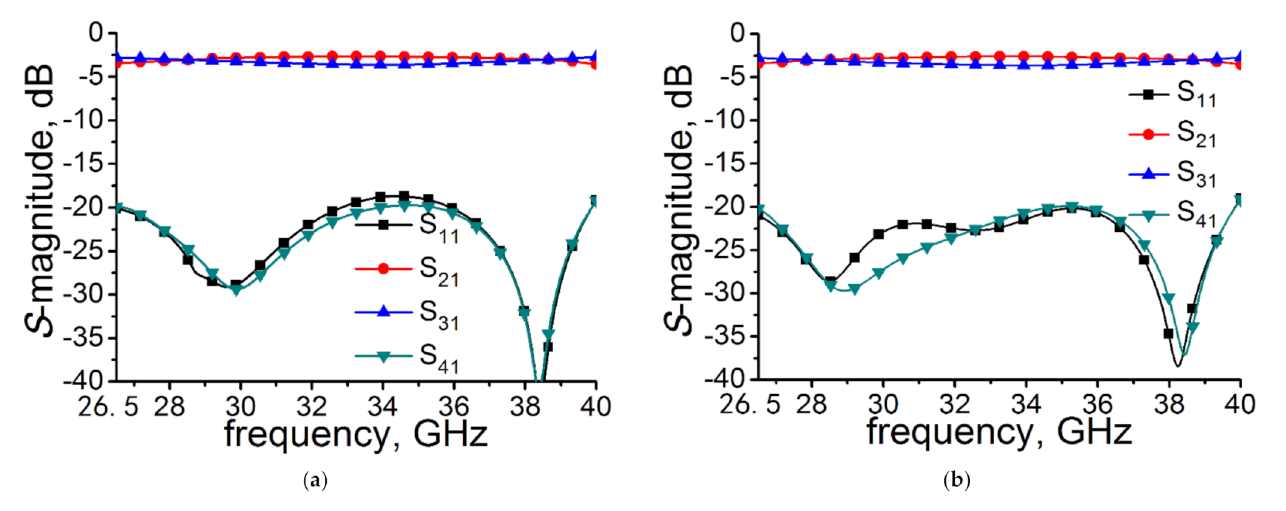
Figure 4. Simulated results of sample coupler ( a ) without transitions and ( b ) with